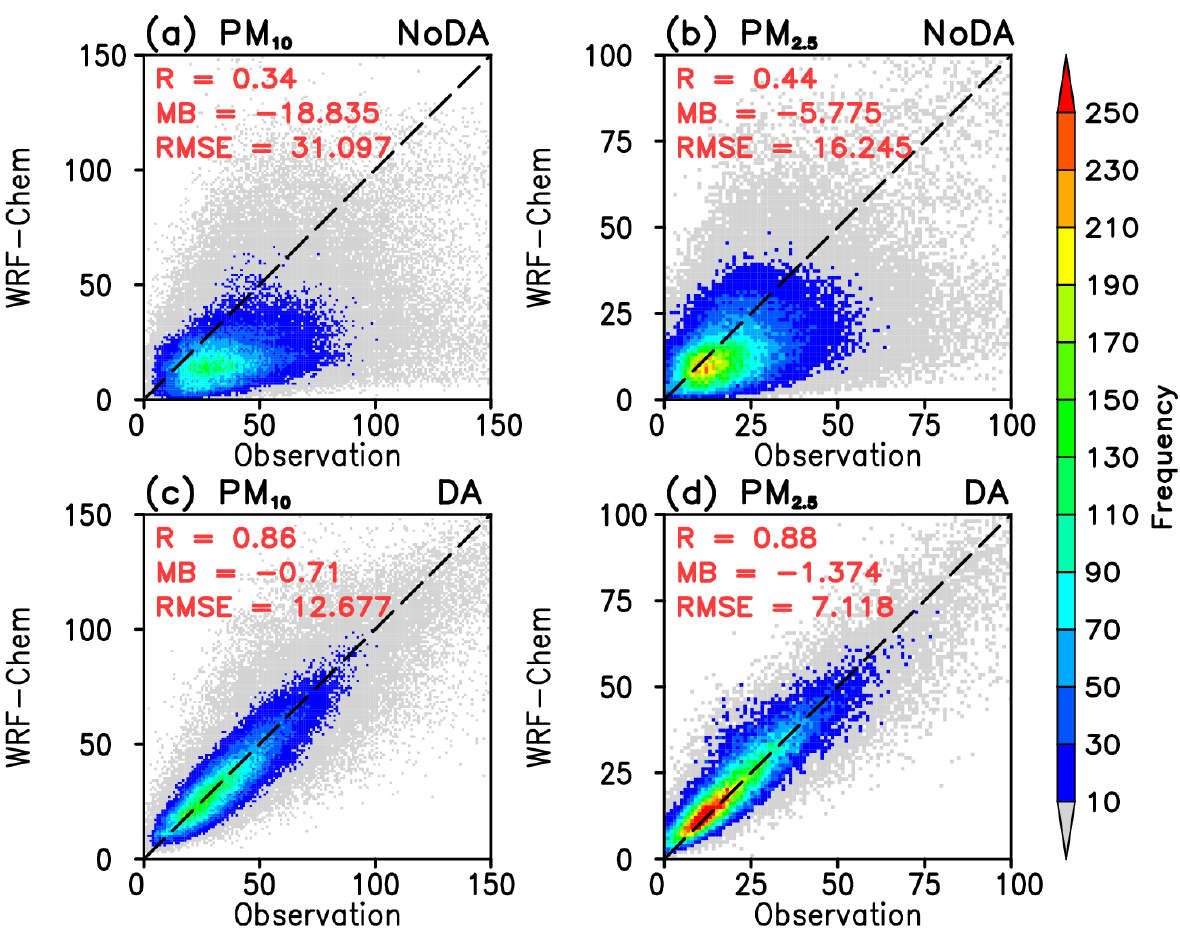
Figure 6. Scatter plots of PM 10 and PM 2.5 values from observations and the model analysis results from ( a , b ) NoDA and ( c , d ) DA experiments over South Korea. The shaded values indicate the frequency. The correlation (R), mean bias (MB), and root-mean-square error (RMSE) values are also provided in each panel.